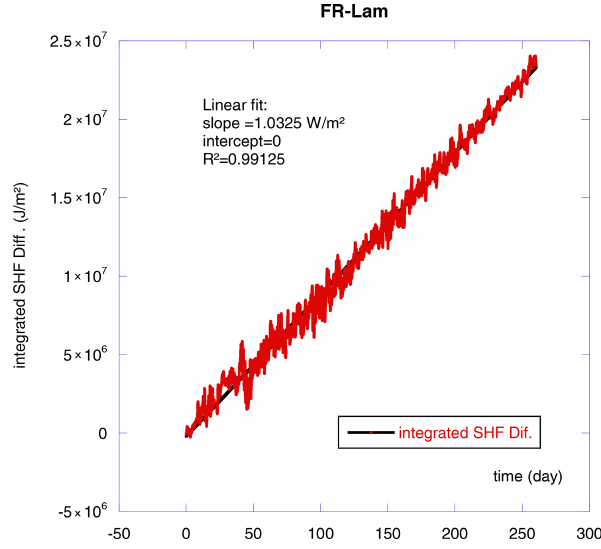
Figure 10. Integrated SHF diff along with linear